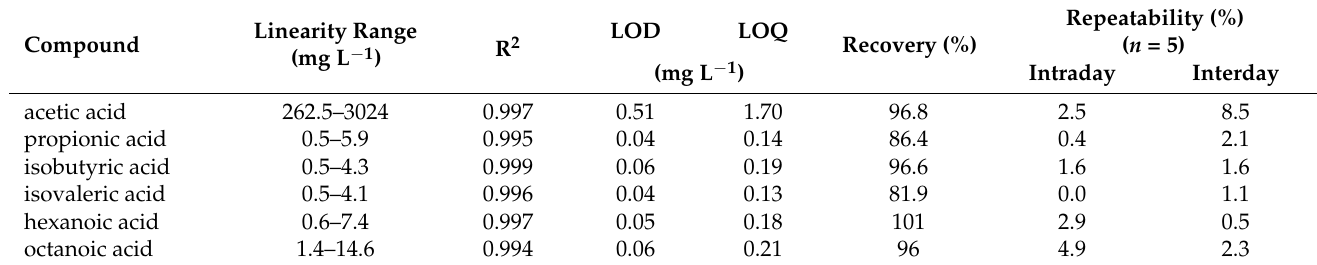
Table 3. Validation